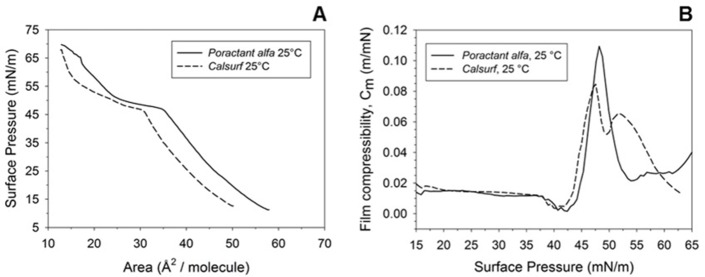
Poractant alfa and Calsurf in compression isotherms and film compressibility.(A) shows the compression isotherms of Poractant alfa and Calsurf, recorded at 25°C using MilliQ ultra-pure water as subphase. Surfactants were spread to an initial surface pressure of ≈ 10 mN/m and subjected to symmetric compression at a rate of 40 cm2/min until film collapse. (B) shows film compressibility (Cm) of Poractant alfa and Calsurf as a function of surface pressure. Each Cm data set was calculated using compression isotherms shown in (A). Cm = -1/A*(δA/δπ), where A is the surface area and π is the surface pressure.